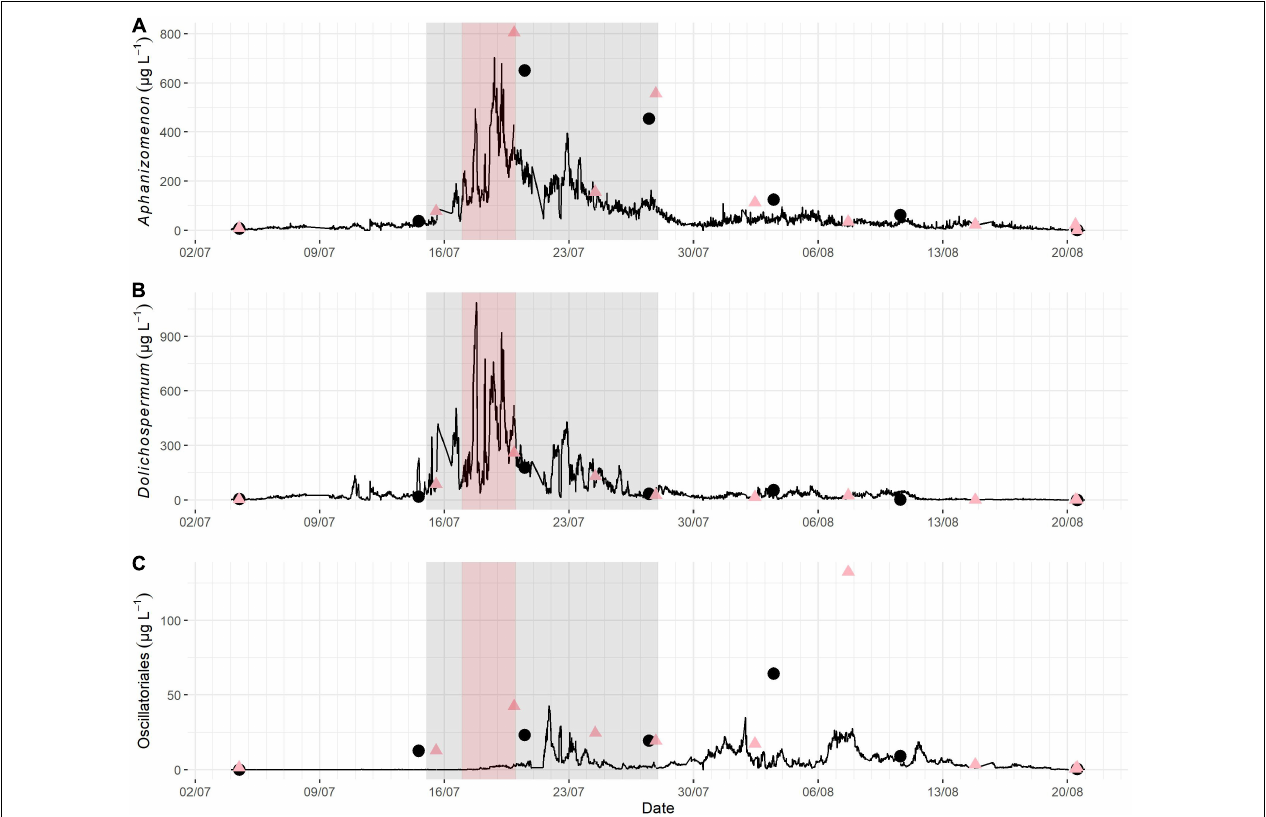
FIGURE 7 | Biomass succession of Aphanizomenon (A) , Dolichospermum (B) and Oscillatoriales (C) during the summer cyanobacterial bloom in Utö in 2018. The Aphanizomenon and Dolichospermum bloom period (defined here as the days of biomass > approximately 100 µ g L − 1 ) is highlighted in gray and the bloom peak period (the days with the highest peaks) highlighted in red. The black dots indicate light microscopy counts from samples taken from the flow-through system, and the red triangles indicate counts from samples taken at the pump inlet. Note the different scales on Y-axis between the